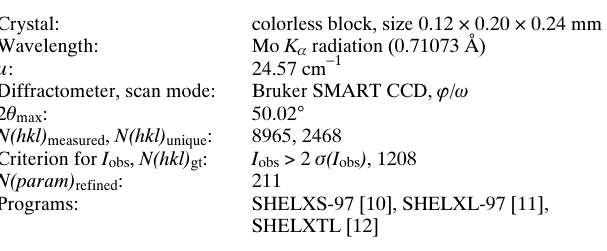
of 109.5° and lie in the range 103.0(1)°  116.8(1)°. The dihedral angle between the C1/C2/C3/C4/C5/C6 plane and the C13/C14/ C15/C16/C17/C18 plane is 87.4(4)°. The equation of the C10/ C11/C12/C13/C18/O1 plane is 5.62(3) x + 5.85(3) y  2.5(1) z = 2.2(1) with atom C10 lying only 0.0104 Å from the plane. Al- though atom C10 has sp 3 hybridization and the ring is not an aro- matic ring, all the six atoms on the ring lie on the same plane. The dihedral angle between the C10/C11/C12/C13/C18/O1 plane and the C13/C14/C15/C16/C17/C18 plane is 1.7(7)°, which shows the two rings are basically on the same plane. The equation of the C1/C6/C7/N1 plane is 4.99(5) x  3.90(5) y + 16.9(2) z = 14.0(2). The deviation of atom C10 from the plane being 0.3836 Å is rela- tively large, which shows the five-membered ring composed of C1,C6,C7,N1,C10 is in an envelope conformation. The dihedral angle between this plane and the C1/C2/C3/C4/C5/C6 plane is 4(1)°. Table 1. Data collection and handling.